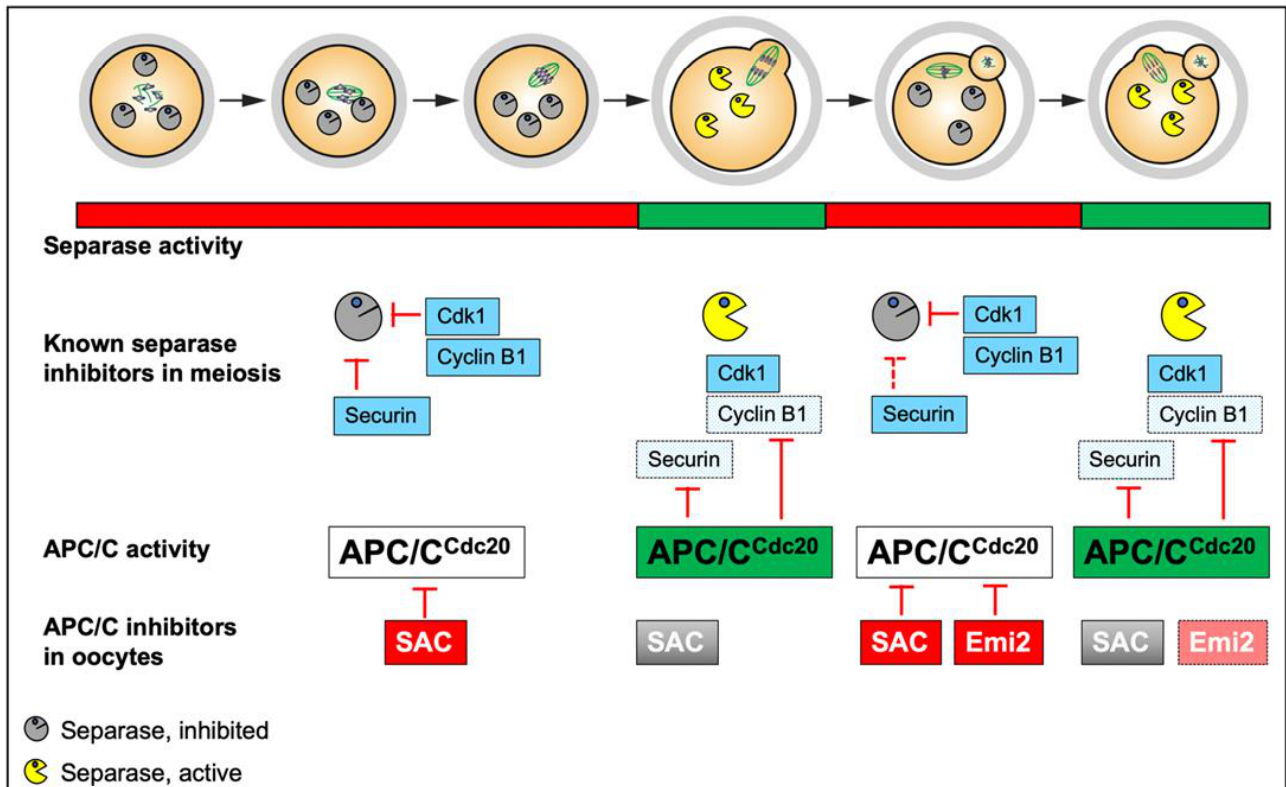
Figure 2. Inhibitory mechanisms controlling separase that have been described in oocyte meiosis. Separase undergoes two activation cycles throughout the two meiotic divisions, indicated in red (inactive) and green (active). Two mechanisms have been shown for up to now to keep separase under control in mouse oocytes: cyclin B1-Cdk1 dependent phosphorylation of separase and binding to securin. Both cyclin B1 and securin are targets of APC/C Cdc20 -dependent ubiquitination followed by their degradation, separase activation thus depends on APC/C Cdc20 activation (indicated by the green color). In oocytes, APC/C Cdc20 activity is under the control of the SAC, which is inactivated once error-free attachments of chromosomes to the bipolar spindle have been achieved, and Emi2, which inhibits the APC/C Cdc20 in meiosis II until fertilization occurs, inducing degradation of Emi2. Lighter shades of the same entity indicate inactivation or degradation.